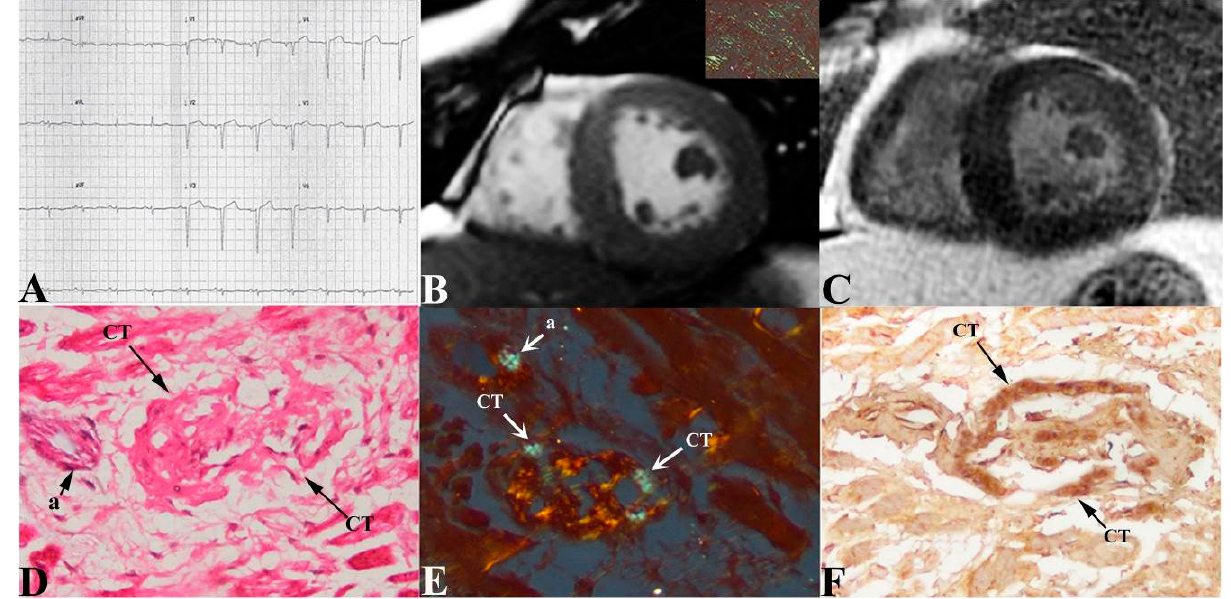
Figure 2. Mild infiltration of CT in cardiac amyloid. Low QRS voltages with absence of brady and/or tachyarrhythmias ( panel ( A )) are associated at CMR with severe LV hypertrophy ( panel ( B ), MWT 20 mm). CineMR images show some slight “patchy” areas of LGE at mid-ventricular lateral wall ( panel ( C )). Apple-green birefringent material at polarized light of Congo Red-stained myocardial sections is visible in insert in panel B. Histology ( panel ( D ), hematoxylin and eosin 400 × ), Congo Red staining ( panel ( E ) 400 × ) and immunohistochemistry for HCN4 ( panel ( F ), 400 × ) show mild infiltration of CT (conduction tissue) (arrows). a = arteriole CT = conduction